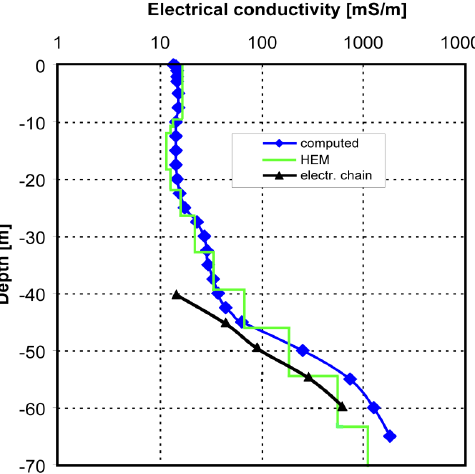
Fig. 15. Comparison of HEM conductivities (green) and CLIWAT II Figure 15. Comparison of HEM conductivities (green) and CLIWAT II vertical electrode 2 vertical electrode chain conductivities (black) with conductivities computed by the model chain conductivities (black) with conductivities computed by the model (blue). 3